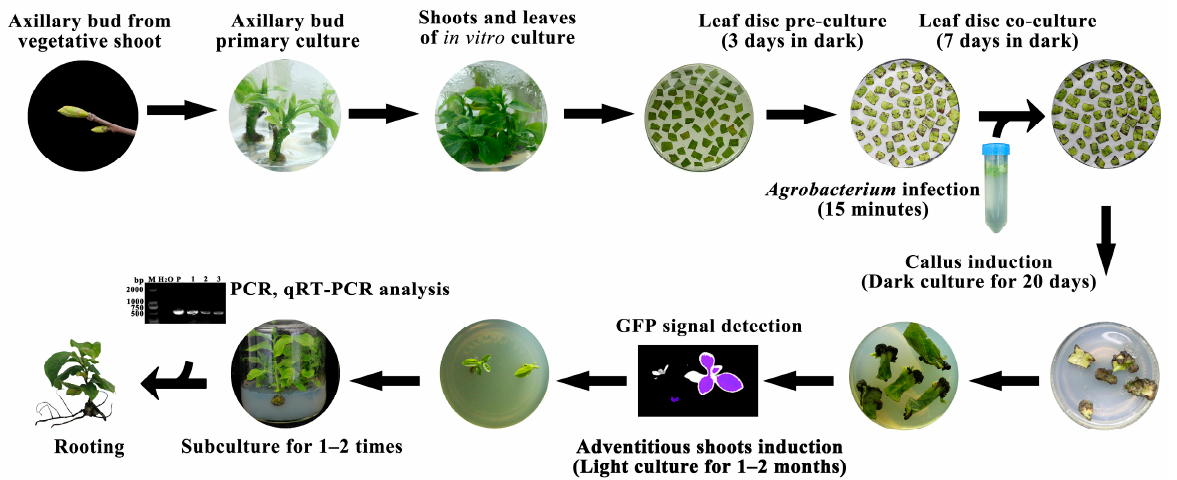
Figure 5. Illustration of the experimental procedure for regeneration of sprouting buds and genetic transformation in persimmon leaves.